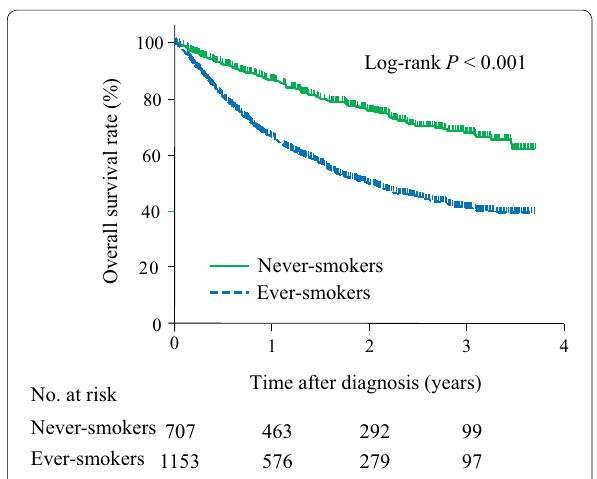
Fig. 2 Kaplan‑Meier overall survival curves of 1860 patients with non‑small cell lung cancer (NSCLC) according to smoking